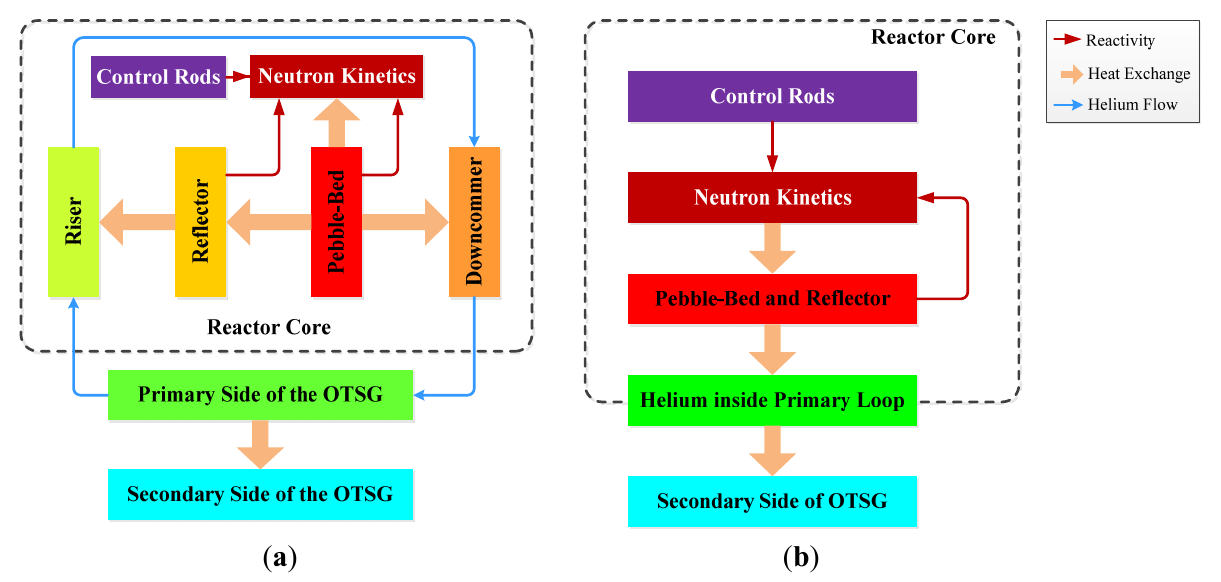
Figure 2. Nodalization of the primary loop: ( a ) old scheme; and ( b ) new scheme. OTSG: once-through steam